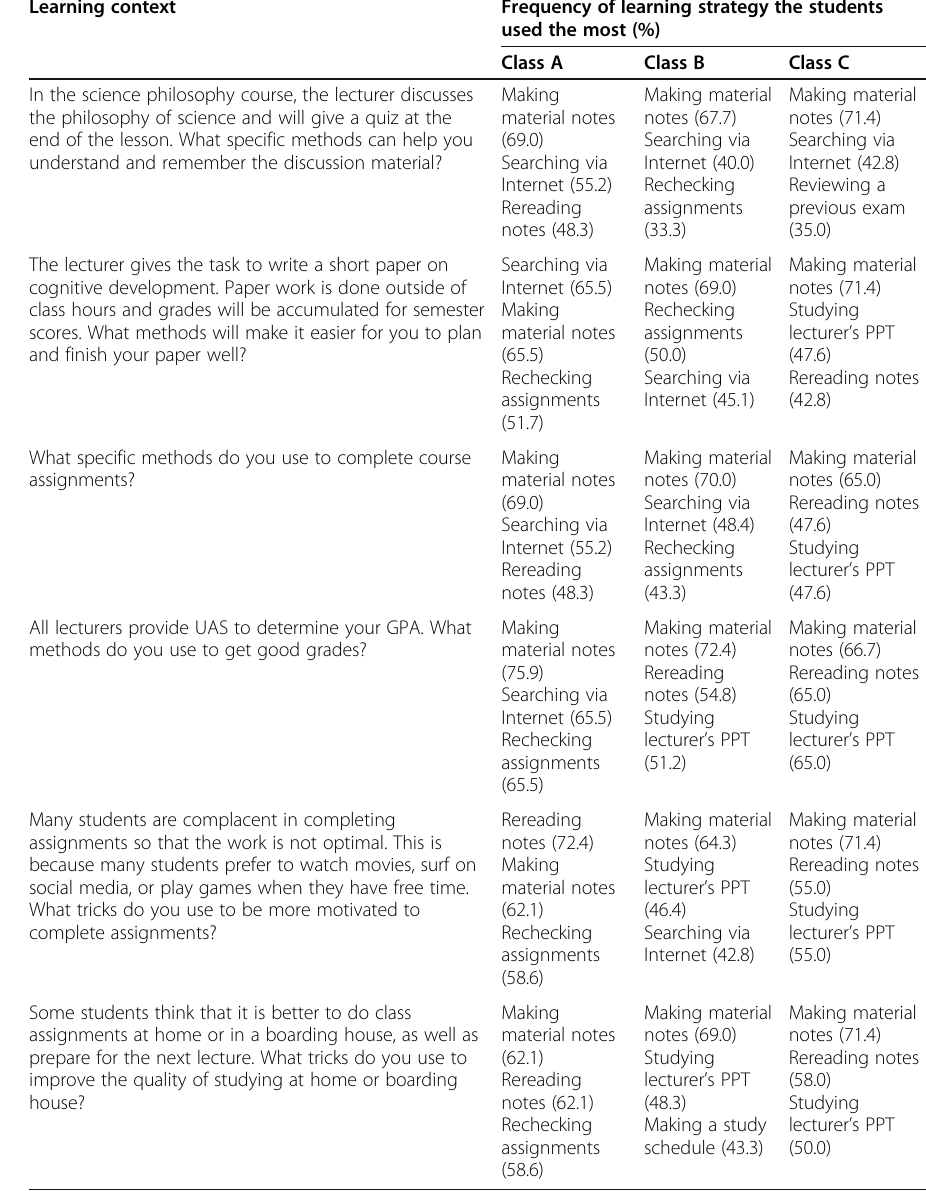
Table 6 Frequency of learning strategies used by students within 6 different learning contexts using each of the 14 SRL learning strategies (most